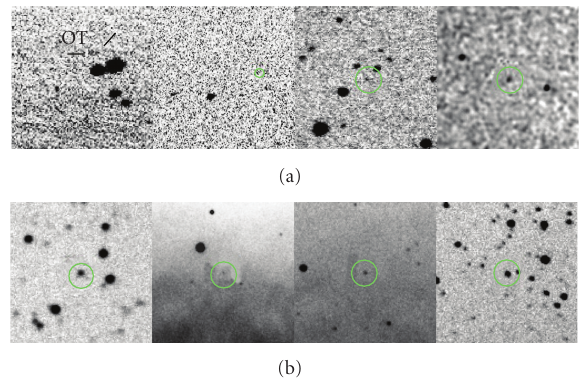
Figure 3: GRB optical transient detections by BOOTES-1B: (a) GRB 050824, GRB 050922C, GRB 051109A, GRB 080330. (b) GRB 080413B, GRB 080430, GRB 080602B, GRB 080605.